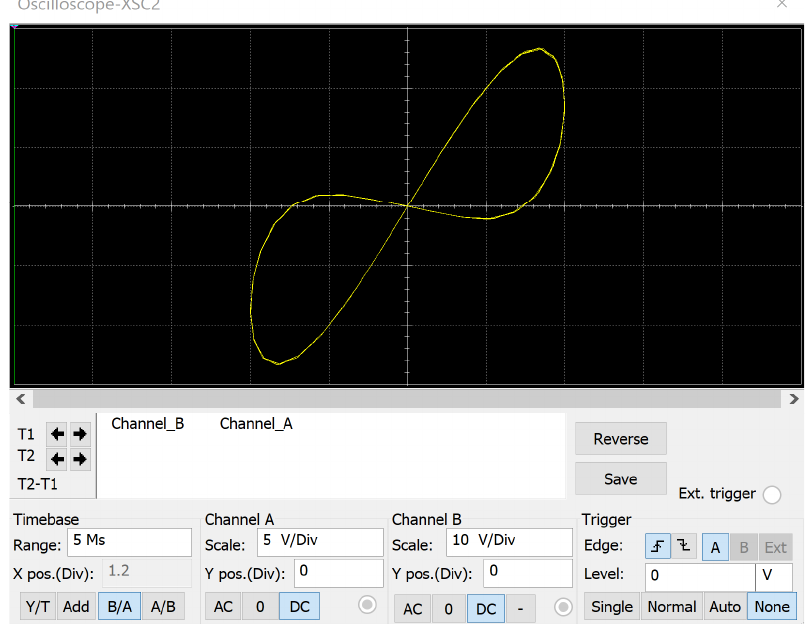
Figure 5. The 𝑞 (cid:3014) − 𝑣 (cid:3014) characteristic curve of fractional-order memcapacitor realized circuit.